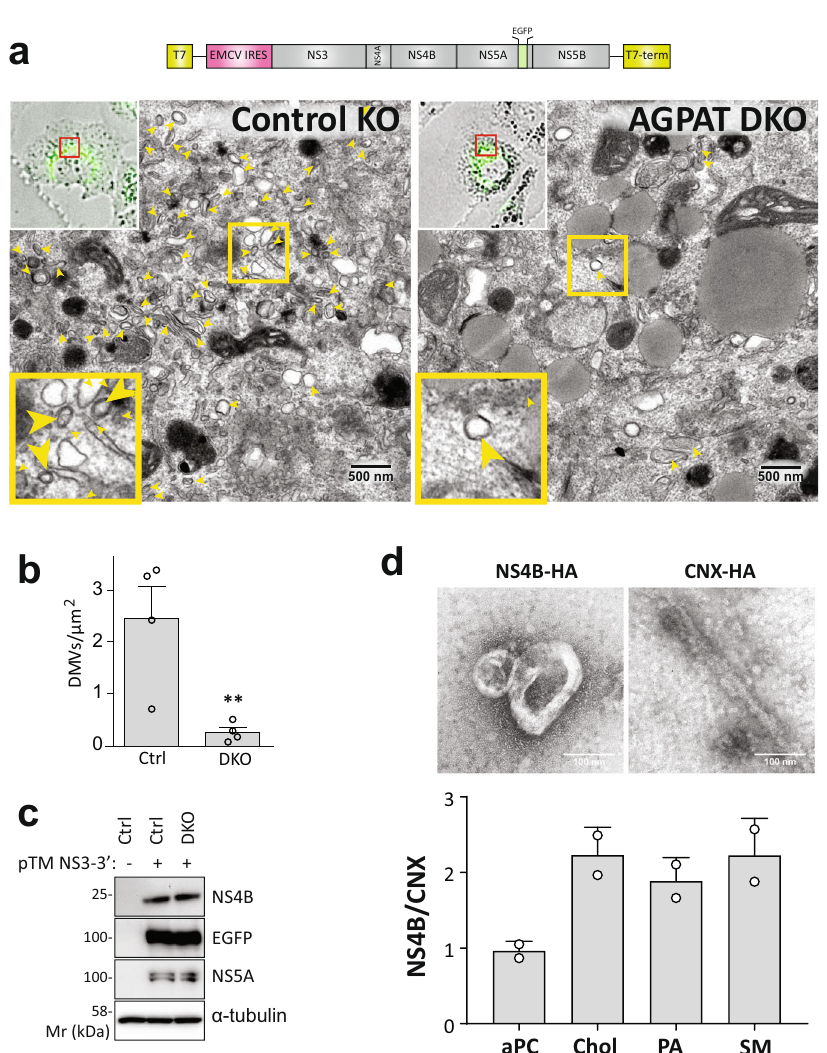
Fig. 3 Requirement of AGPATs for HCV DMV formation. a – c AGPAT1/2 DKO dampens DMV formation induced by HCV. Huh7-derived cells stably expressing T7 RNA polymerase and containing or not a double knock-out (DKO) of AGPAT1 and 2 were transfected with HCV replicase-encoding plasmid containing a GFP insertion in NS5A (construct pTM NS3-3 ’ /5A-EGFP, top panel). Transcripts are generated in the cytoplasm via the T7 promoter and terminator (T7-term) sequence and the HCV NS3 – 5B coding region is translated via the IRES of the encephalomyocarditis virus (EMCV). a After 24 h, cells were fi xed and subjected to CLEM. Low-resolution confocal microscopy images identifying transfected cells are shown on the top left. The area in the red box is shown in the corresponding EM image. Yellow arrow heads indicate DMVs. Insets on the bottom indicate zoomed-in regions. b DMVs within whole-cell sections were counted and divided by cell area ( µ m 2 ). Graph shows average and SD from four different transfected cells. Cells expressing comparable level of HCV replicase were selected for EM analysis. Signi fi cance was calculated by two-tailed paired t -test. p = 0.0128. c Expression levels of NS4B and NS5A in transfected cells were determined by western blotting. d Lipidome analysis of HCV-induced DMVs. Extracts of Huh7 cells containing the subgenomic replicon sg4BHA31R (NS4B-HA) or stably overexpressing HA-tagged Calnexin (CNX-HA) and control Huh7 cells were used to enrich for DMVs (NS4B-HA) and ER membranes that served as reference (CNX-HA). An aliquot of the sample was analyzed by electron microscopy (top panels) whereas the majority was subjected to lipidome analysis. Representative membrane structures are shown on the top: DMV-like vesicles in the NS4B-HA sample (left) and single membrane tubes in the CNX-HA sample (right). Amounts of selected lipids determined by MS for the NS4B-HA sample were normalized to those obtained for the CNX-HA sample that was set to one (bottom panel). The complete list of analyzed lipids is summarized in Supplementary Data 3. Data are represented as mean ± SD from two biologically independent experiments. Source data for panels b and c are provided as Source Data fi phosphorylation of diacylglycerol (DAG) by diacylglycerol kinase relocalization of PA to LC3 puncta during nonselective (DAGK) 27 , did not contribute to PA accumulation or increase in autophagy, PA inhibitors targeting PLD1, PLD2, and AGPATs, LC3 puncta during nonselective autophagy (Supplementary applied as short-term treatments and at non-toxic concentrations, Fig. 7). signi fi cantly reduced the accumulation of LC3 puncta (Supple- mentary Fig. 7). These fi ndings are consistent with a recent study suggesting that PA generated on the ATG16L1-positive autopha- Recruitment of AGPATs to SARS-CoV-2 induced DMVs and gosome precursor membrane contributes to autophagosome contribution to viral replication . Having found that AGPAT1 formation 30 . Of note, a third pathway for PA production via